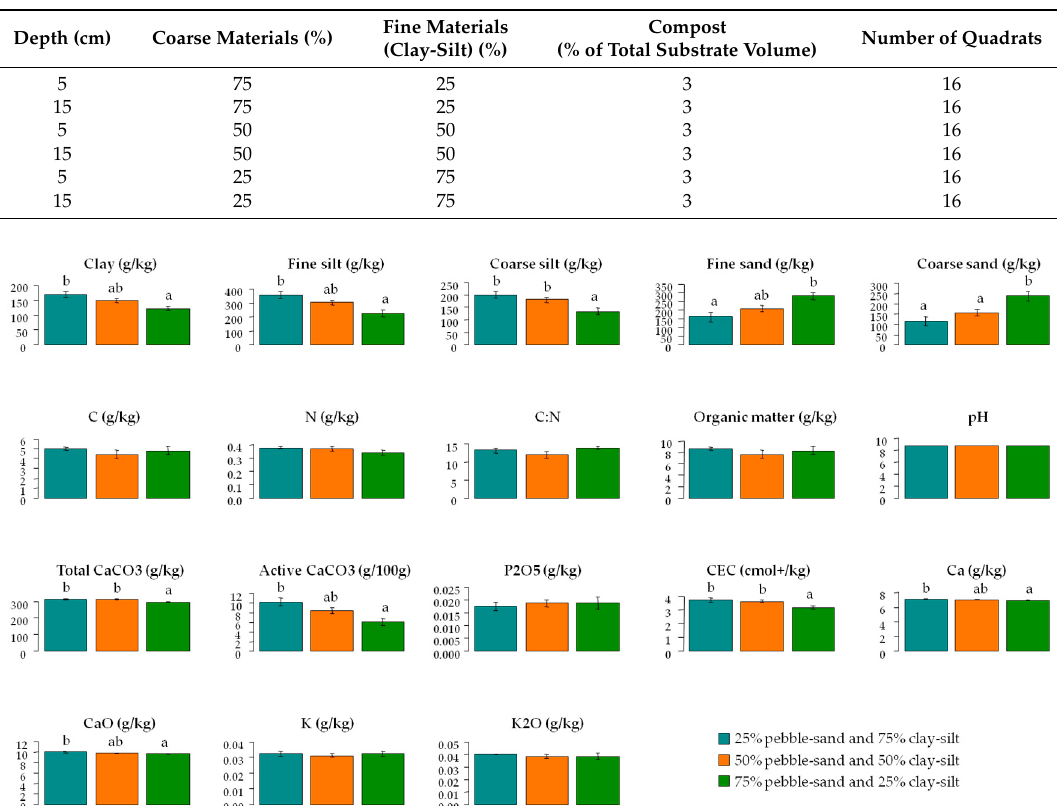
Table 1. Composition of the six substrates tested on the green roof.